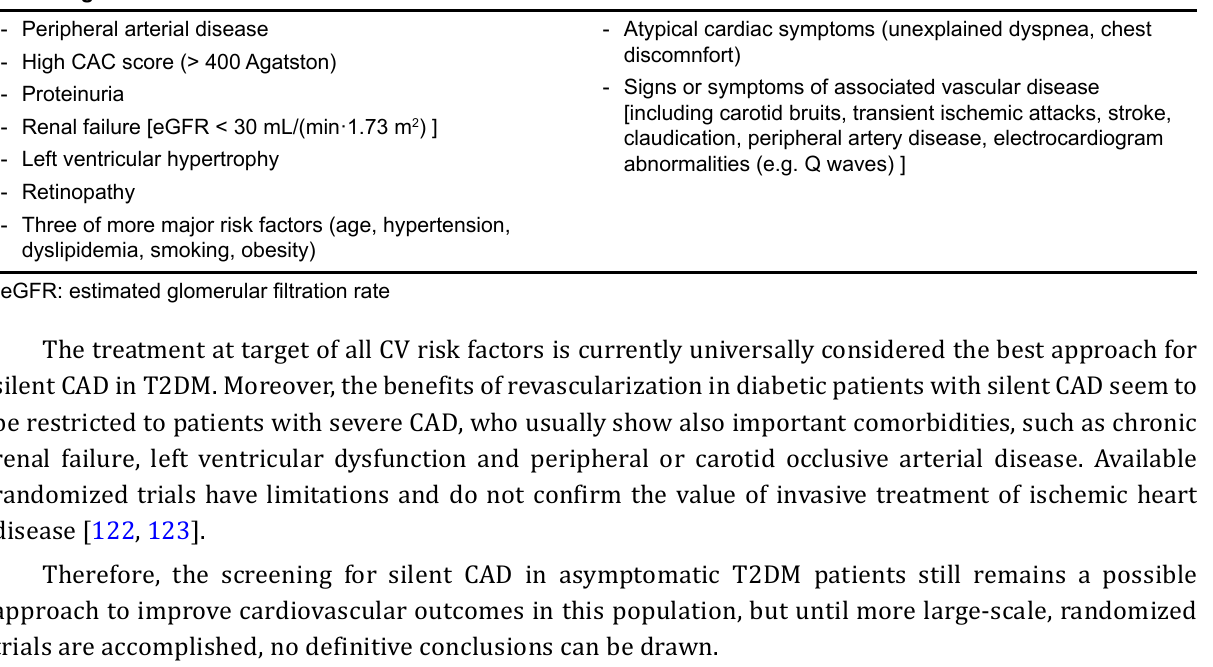
Table 3. Criteria suggested by ESC 2019 [19] and ADA 2020 [21] for considering the screening of CAD in type 2 asymptomatic diabetic patients ESC 2019: patients at very high risk, i.e. with any of